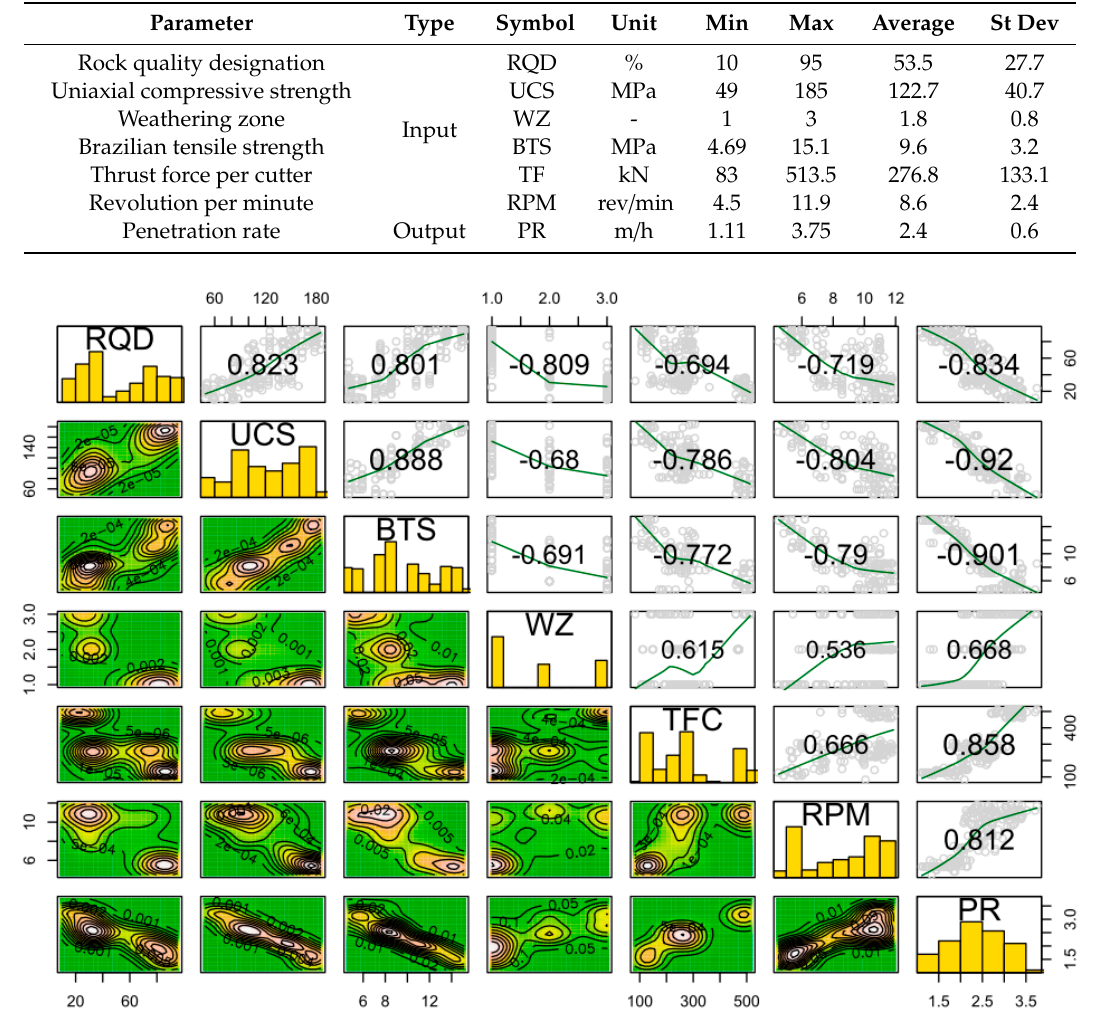
Table 3. Descriptive statistics of the experimental database used in this research.